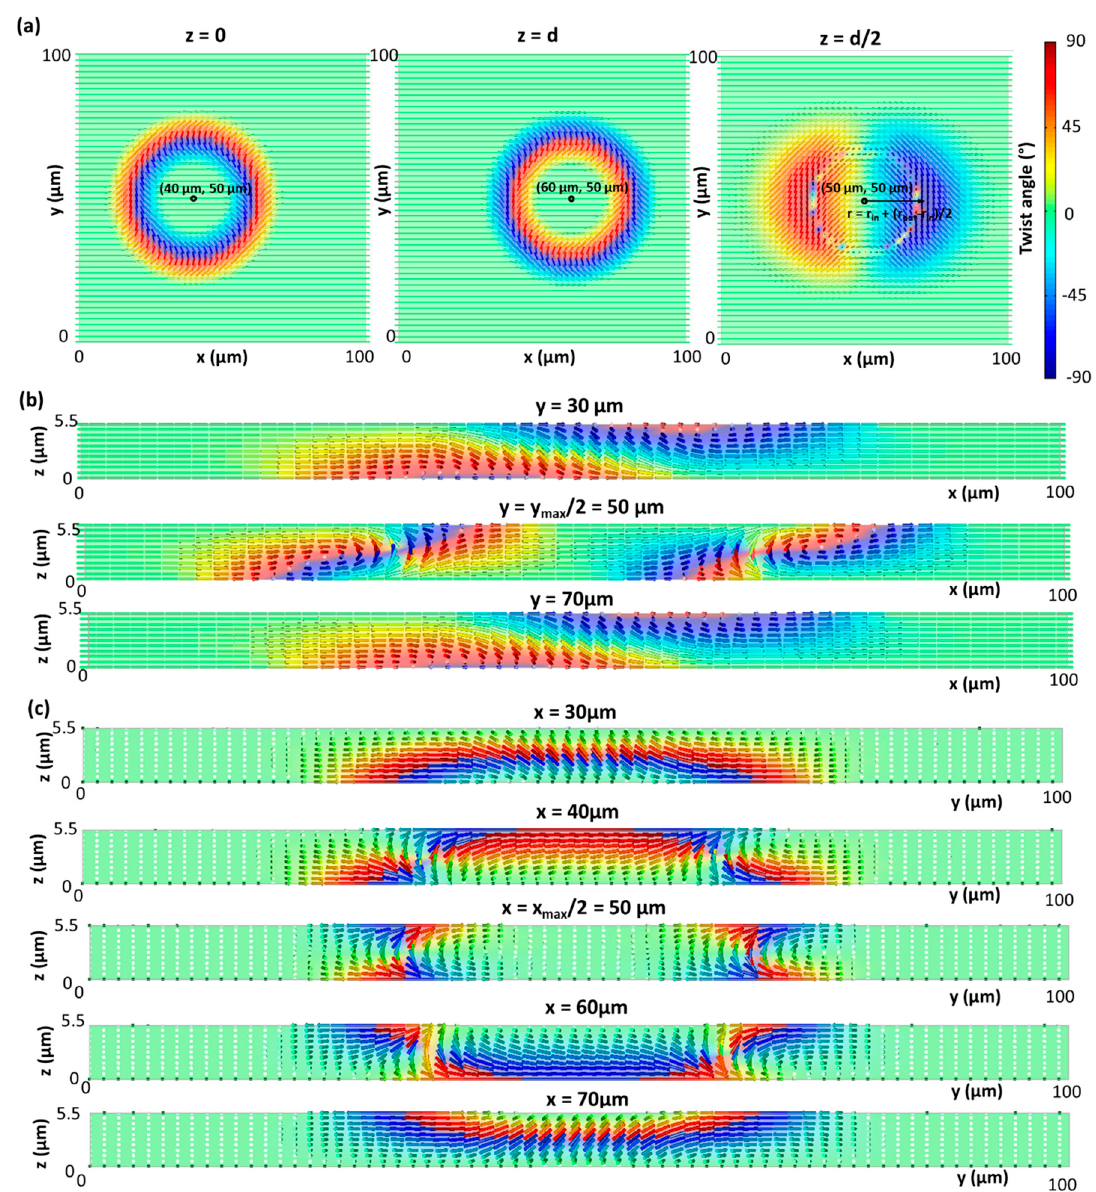
Figure 9. Simulated director configuration in configuration 2 (100 µ m × 100 µ m × 5.5 µ m unit cell) with a 20 µ m shift between the centra of the patterned rings at the top and bottom substrate (r out = 30 µ m, r in = 0.4 * r out ). The color represents the twist angle with respect to the x-axis. The director configuration is shown at the bottom substrate, the top substrate and the mid-plane z = d / 2 ( a ), and in di ff erent perpendicular cross-sections for y = constant ( b ) and x = constant ( c ).